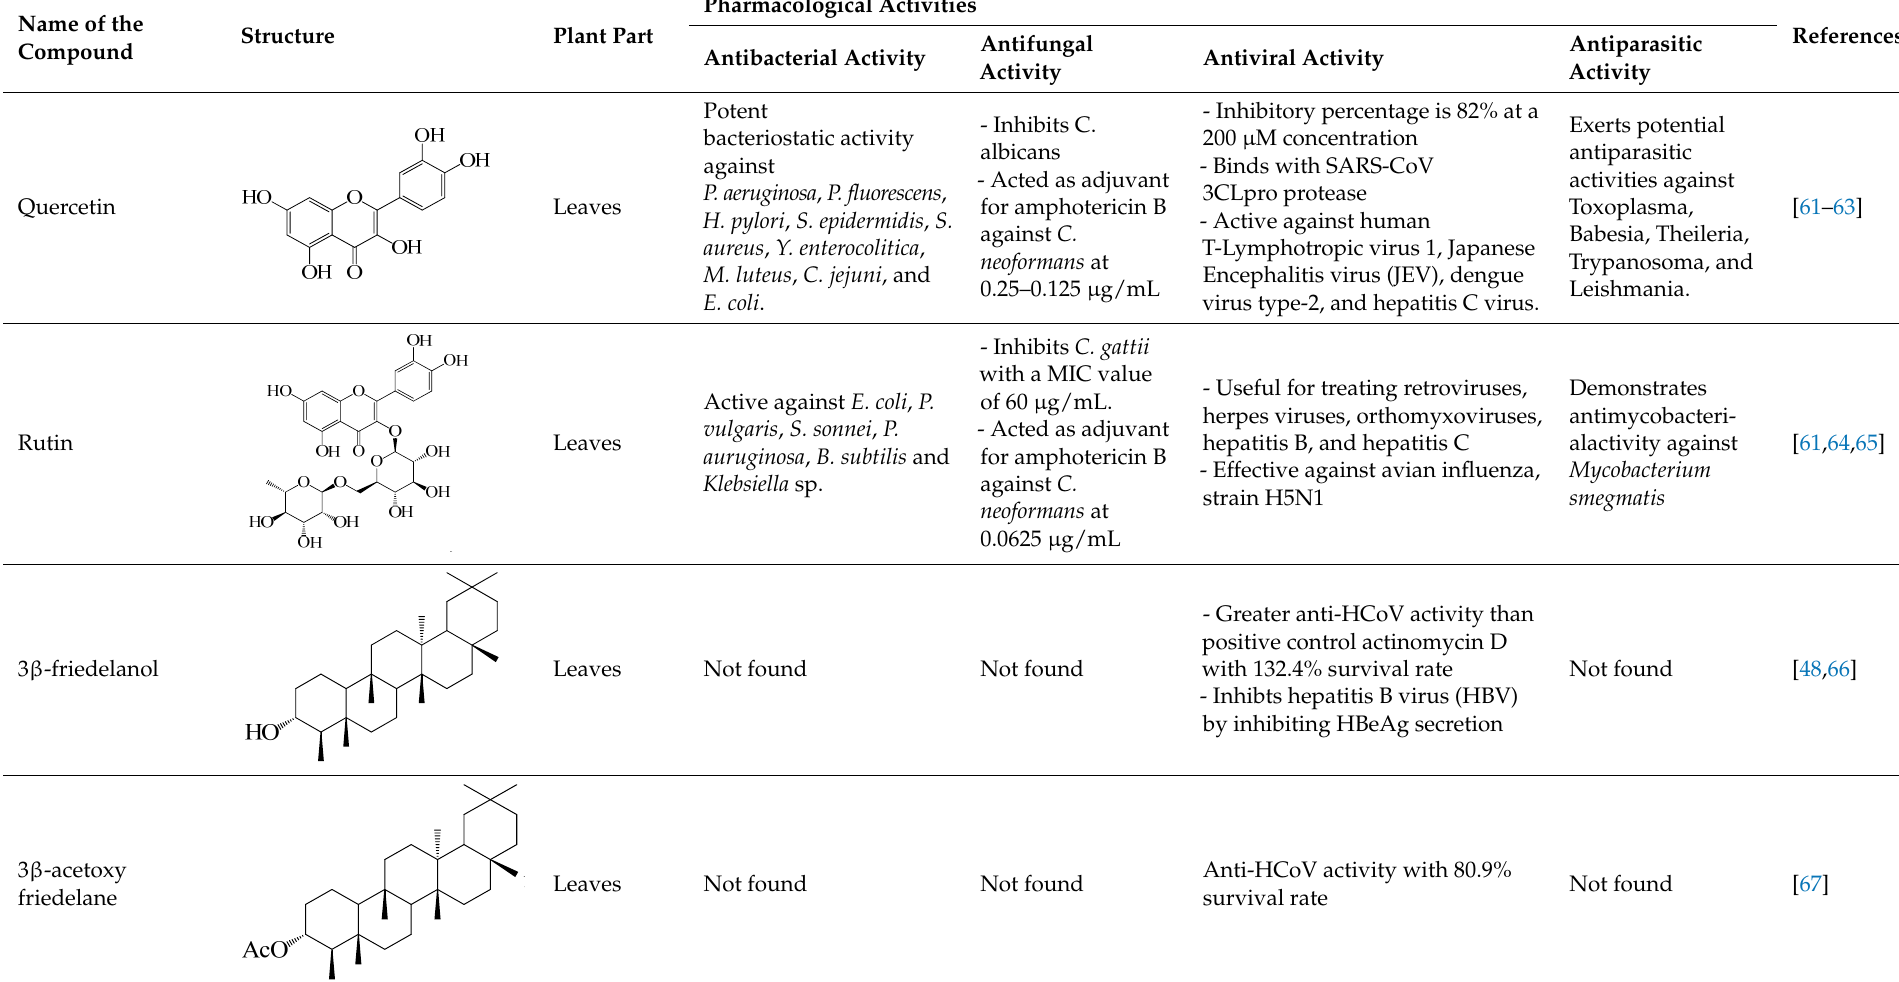
Table 2. Major compounds present in different parts of E. neriifolia and their antimicrobial activities.